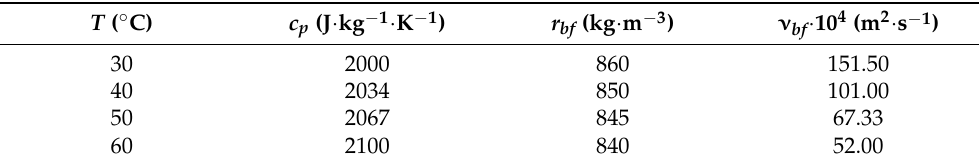
Table 7. Thermophysical parameters assumed for the calculation of the Prandtl number in Equation (24).